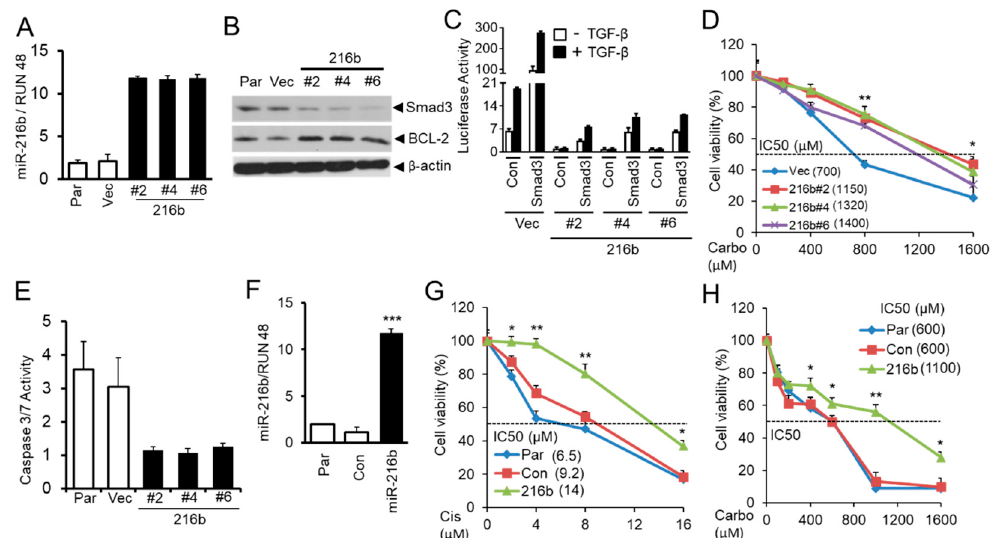
Figure 6. MiR-216b upregulates BCL-2 and promotes resistance of lung cancer cells to chemotherapy. ( A ) Stable expression of miR-216b in NSCLC cells H460 was tested by qRT-PCR analyses. RUN 48 was used as internal control. ( B ) Western blot analysis for Smad3 and BCL-2 protein levels in H460 cell clones stably expressing miR-216b, parental (Par), and control vector cells with β -actin as loading control. ( C ) H460 clones stably expressing miR-216b or control vector were co-transfected with TGF- β responsive luciferase reporter (CAGA) 9 MLP-Luc and Smad3 expression vector or control vector. Twenty-four hours after transfection, cells were exposed to 5 ng / mL TGF- β 1 for 22 h and then harvested for luciferase activity assay. ( D ) H460 cell clones stably expressing miR-216b or control vector were seeded into 96-well plates at 5000 / well, and then cells were treated with di ff erent concentrations of carboplatin (Carbo) for 5 days. The number of viable cells was determined by MTT assay and the relative percentages of viable cells were presented. The experiment was performed three times with similar results. * p < 0.05, ** p < 0.01. ( E ) Stable clones and parental cells as described in Figure 6B